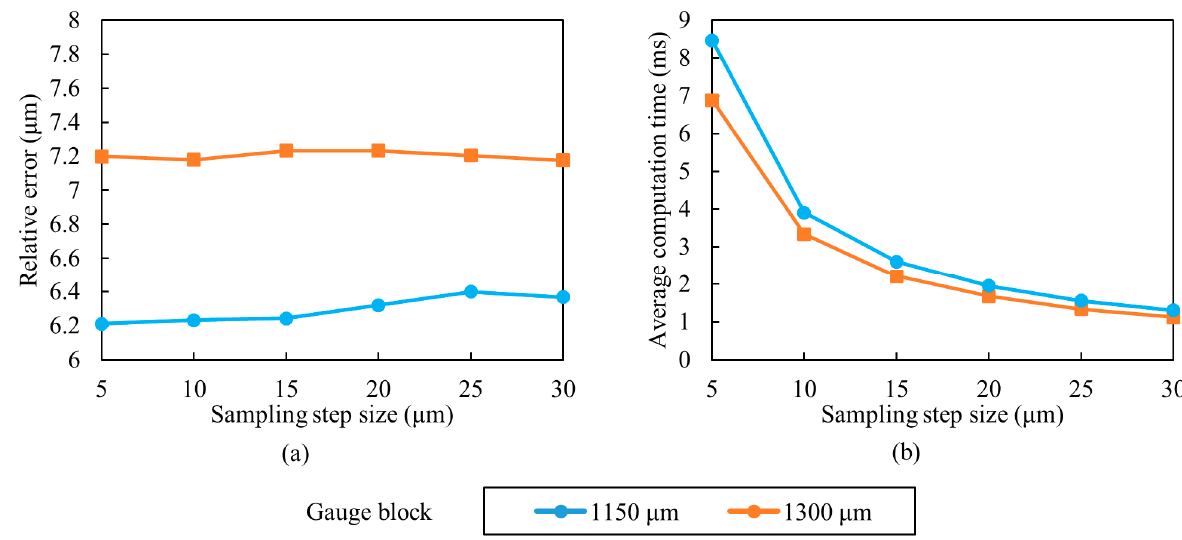
Figure 14. Standard gauge block plane measurement with different sampling step sizes. ( a ) Measurement error and ( b ) Computation time.